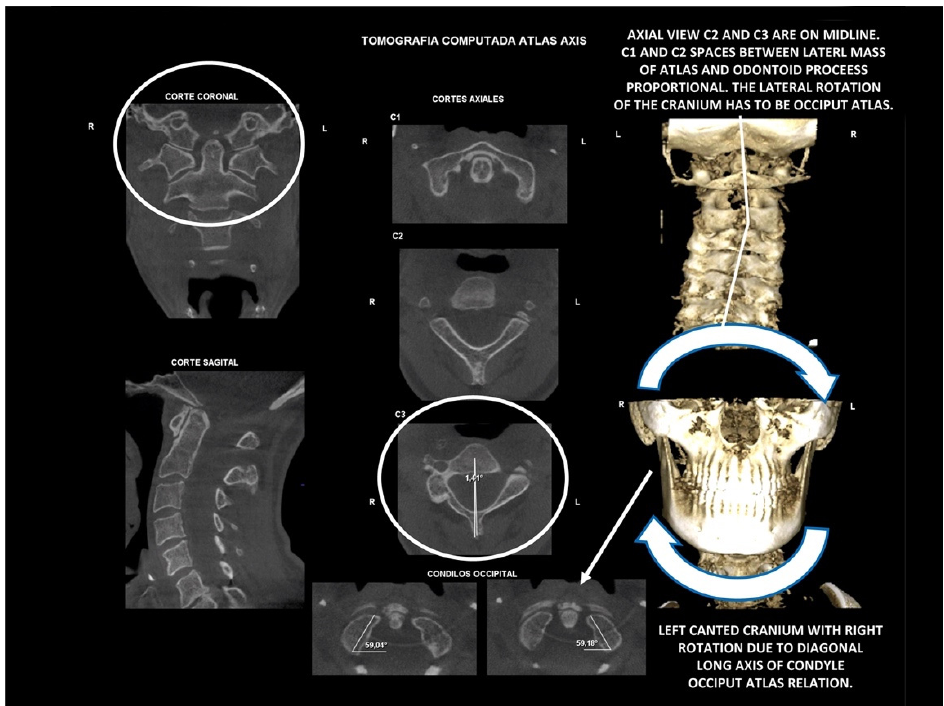
Figure 15. Diagnosis. Atlas - axis three-dimensional high-resolution tomography. The cranium is canted with lower cervical spine compensation. It is an occiput- atlas lateral or coronal plane disorder. Diagnosed as normal axial and coronal atlas - axis relation. Habitually, it is not diagnosed or diagnosed as normal craniovertebral relation.